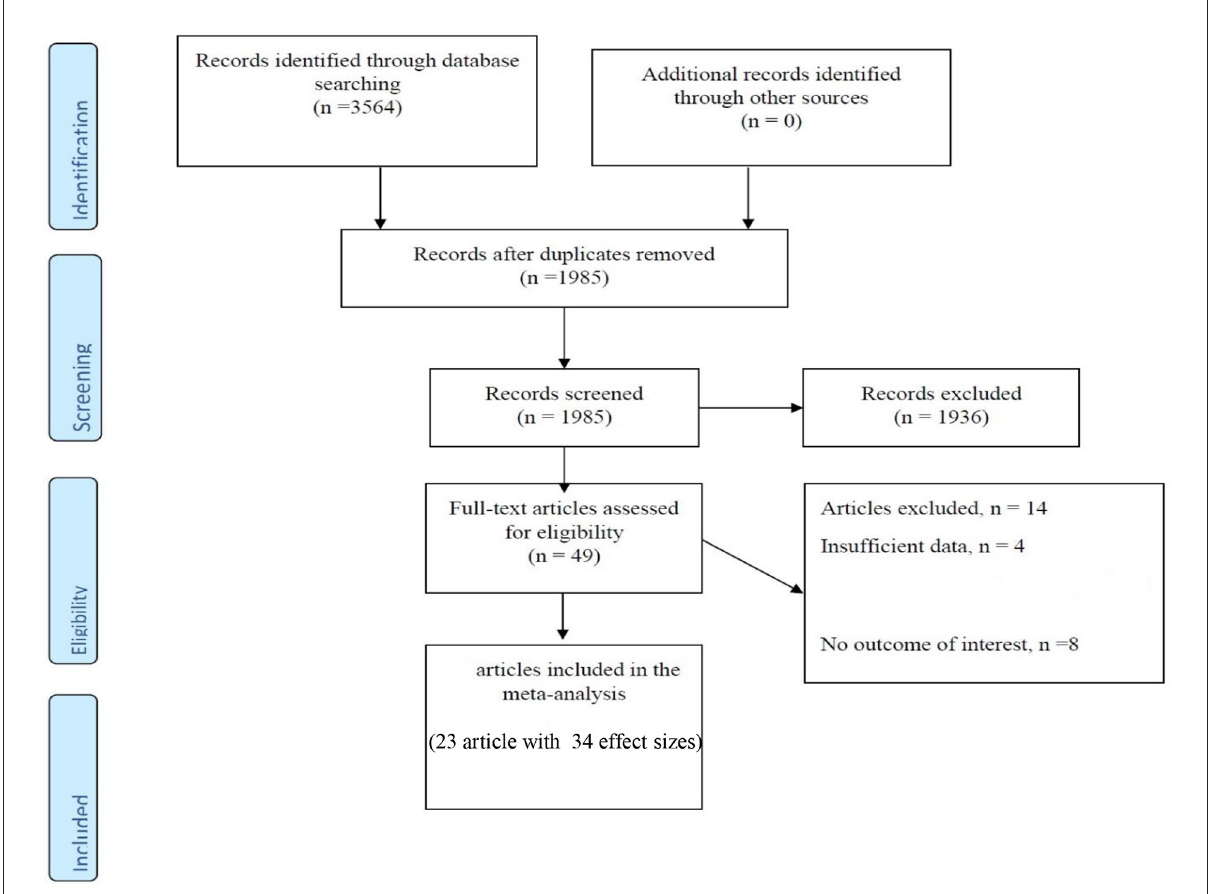
FIGURE1 Flow chart of the included studies, including identification, screening, eligibility and the final sample